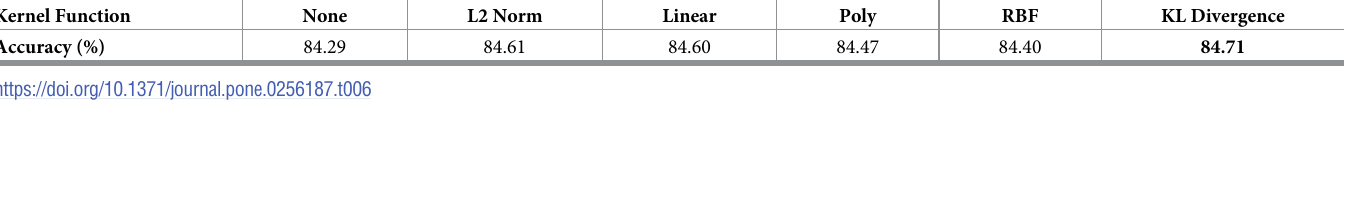
Table 6. Accuracy with different kernel functions in the Cora dataset. Note that KL divergence-based kernel provides the best accuracy, and the student ‘None’ without the embedding distillation shows a poor performance. Kernel